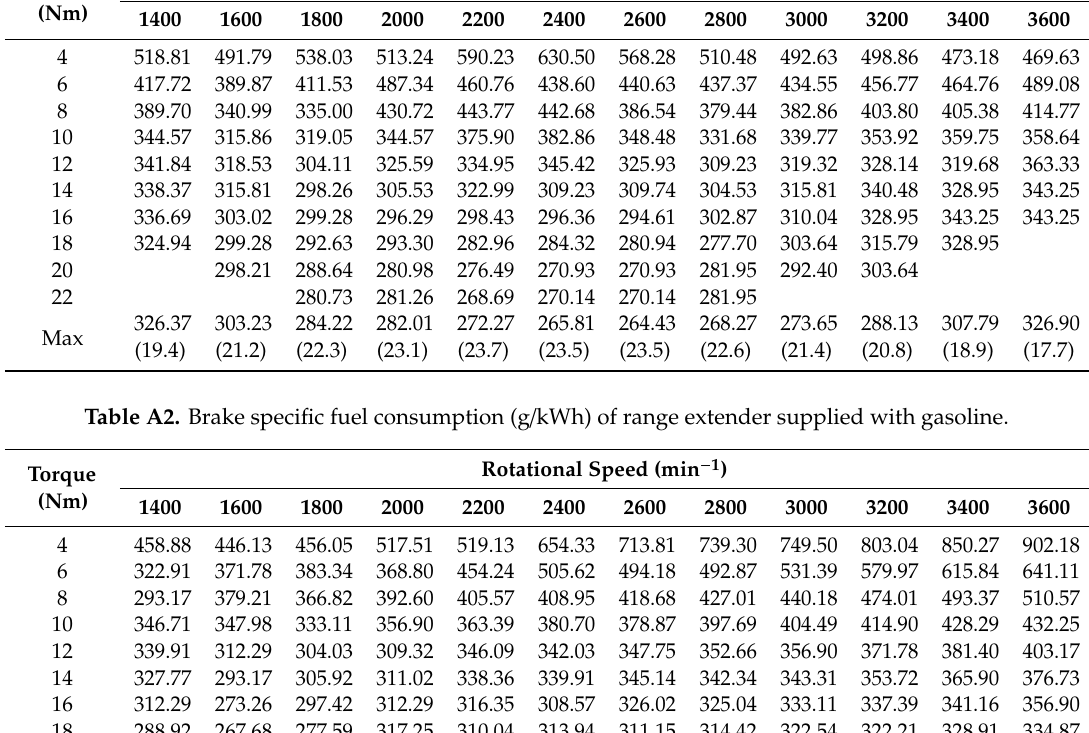
Table A1. Brake specific fuel consumption (g / kWh) of range extender supplied with LPG. Torque